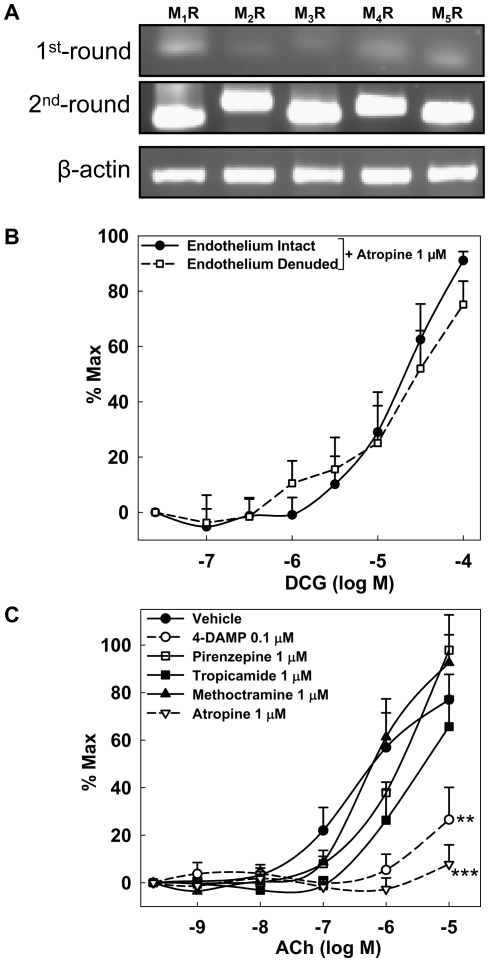
Role of muscarinic receptors in DCG- and ACh-induced reduction of MT in rat 4th-order mesenteric arteries.(A) PCR reveals expression of all muscarinic receptor subtypes (M1R-M5R). mRNAs were extracted from arteries for 3 rats. PCR products, obtained using primers shown in Table 1 (first round), were amplified for 30 cycles with the second-round primers (Table 2). Agarose gel electrophoresis of PCR products is shown. (B) DCG-induced concentration-dependent reduction of MT in endothelium-intact and -denuded arteries preincubated with 1 µM atropine. (C) 1 µM Atropine and 0.1 µM 4-DAMP markedly attenuated ACh-induced reduction of MT. Asterisks indicate significance when compared to vehicle-treated arteries. (n = 4–5 arteries in each group).